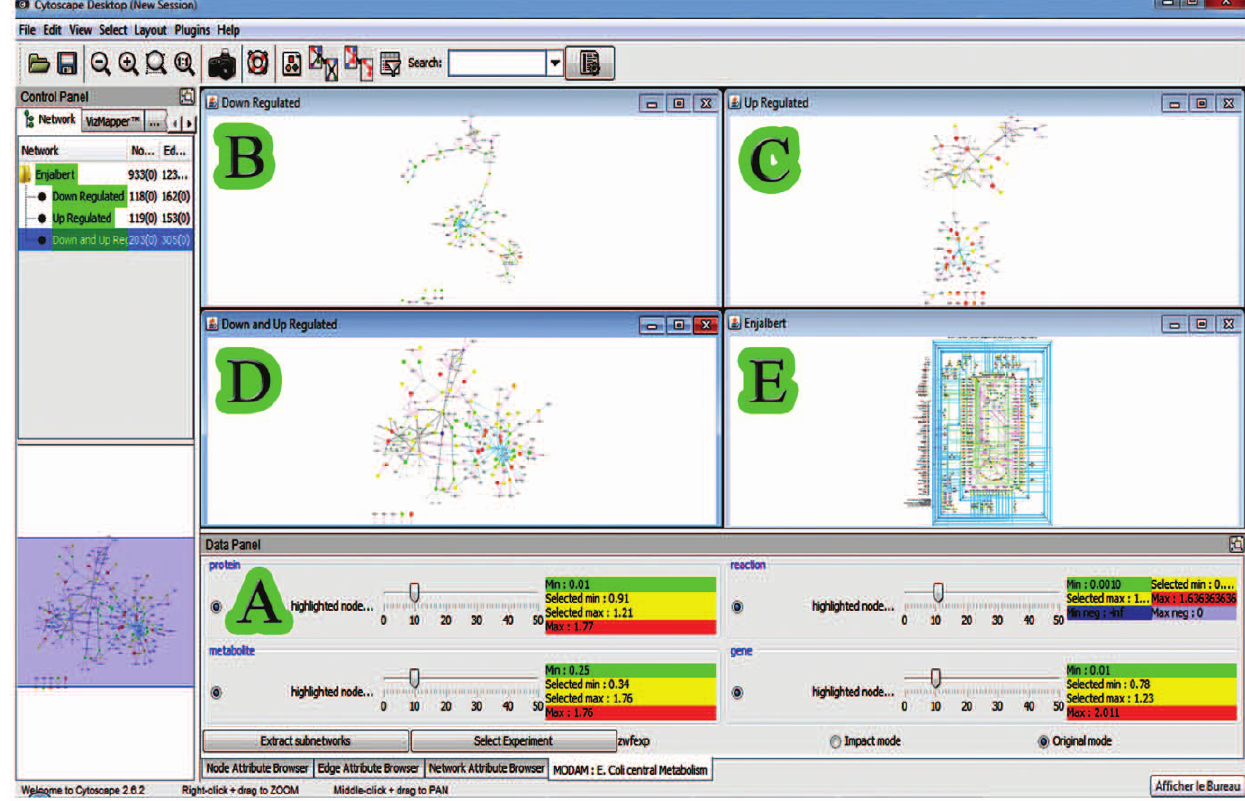
Figure 5. MODAM plug-in interface. The main MODAM interface is the panel below the graph representations (A). For each omics data it is possible to change the coloring threshold expressed in percentage of the significant elements. The user can also select, via the radio buttons, which omics data will be displayed and taken into account for the subnetwork extraction. Note that any modification is directly applied to the view in order to provide an interactive feedback to users. Four representations are available:,the subnetwork of down-regulated elements (B), the sub-network of up-regulated ones (C), the joint up-and down regulated elements subnetwork (D), and the global representation (E).